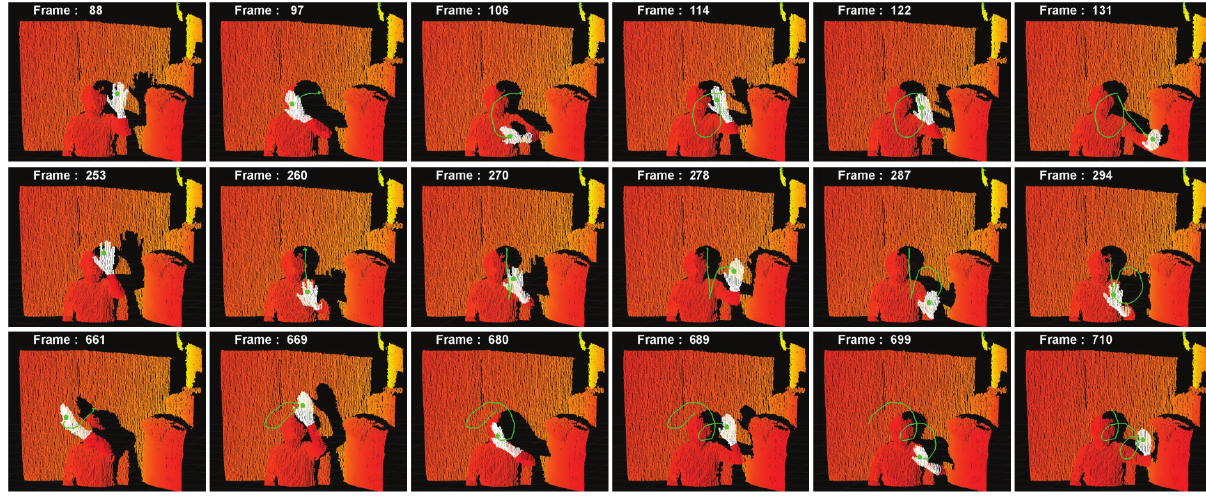
Figure 15: Tracking results. Table 1: Comparison of detection rate and false positive rate of various AdaBoost algorithms.